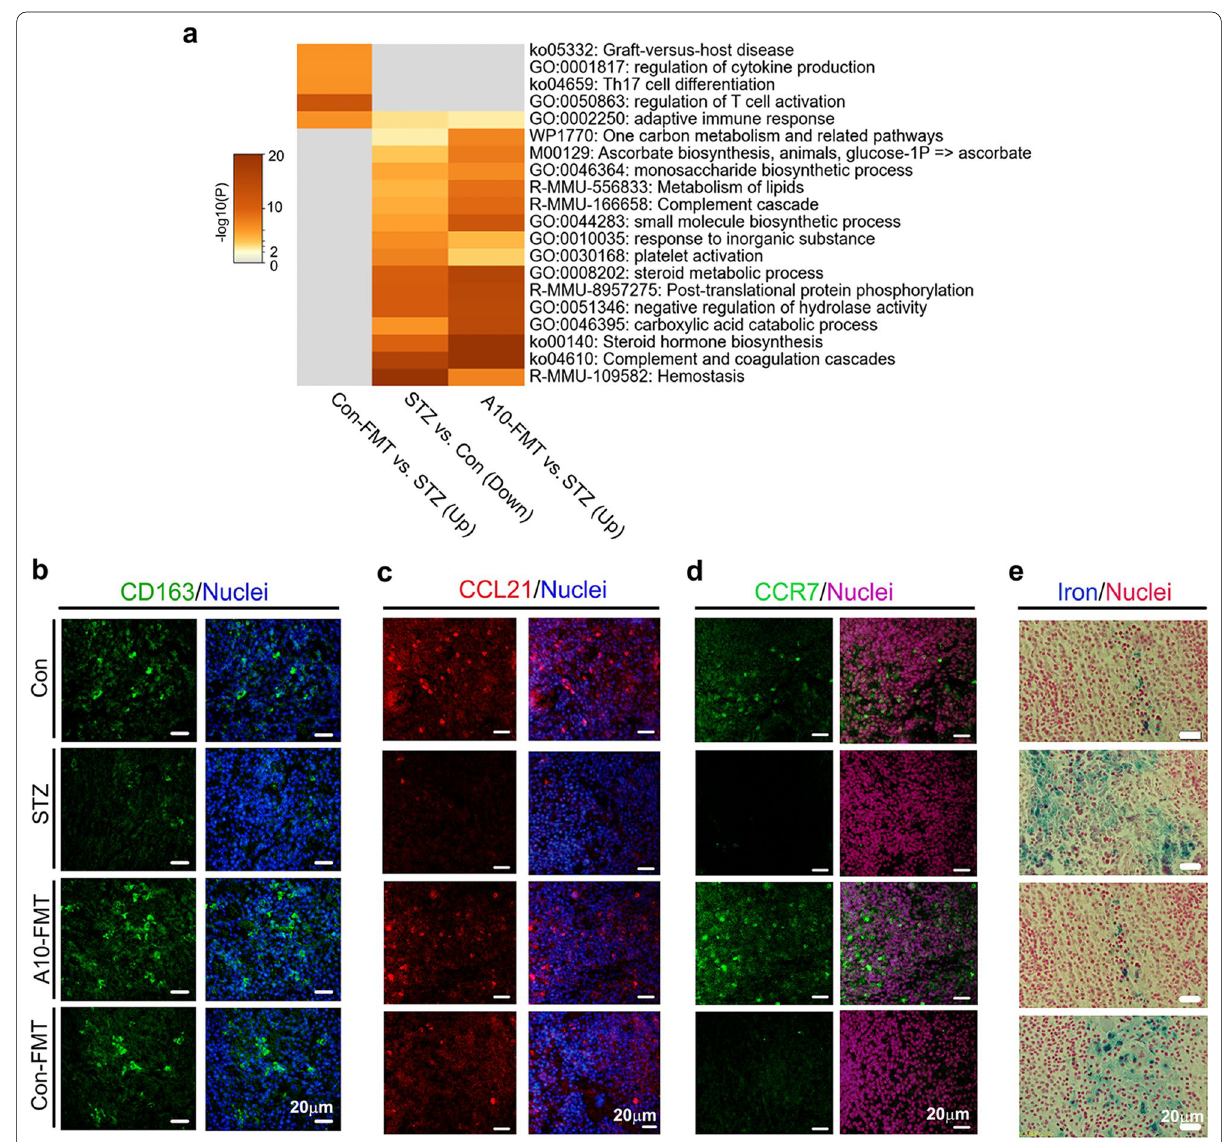
Fig. 6 A10-FMT improved spleen function. a Functional enrichment analysis of STZ decreased genes while they were increased by A10-FMT or Con-FMT. b IHF staining of CD163 in spleen tissue. c IHF staining of CCL21 in spleen tissue. d IHF staining of CCR7 in spleen tissue. e Perl’s Prussian blue stain for ferric iron in spleen tissue. n ≥